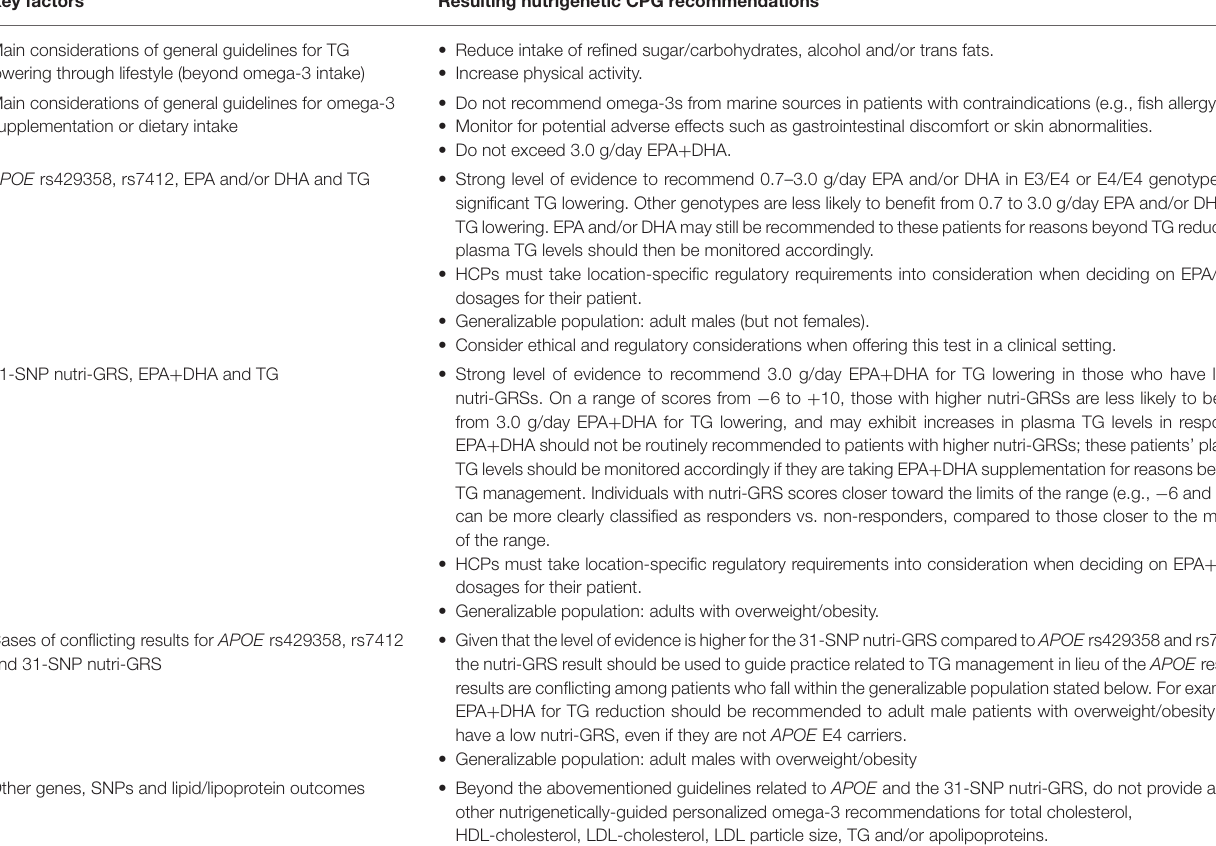
TABLE 2 | Summary of CPG recommendations. Key factors Resulting nutrigenetic CPG